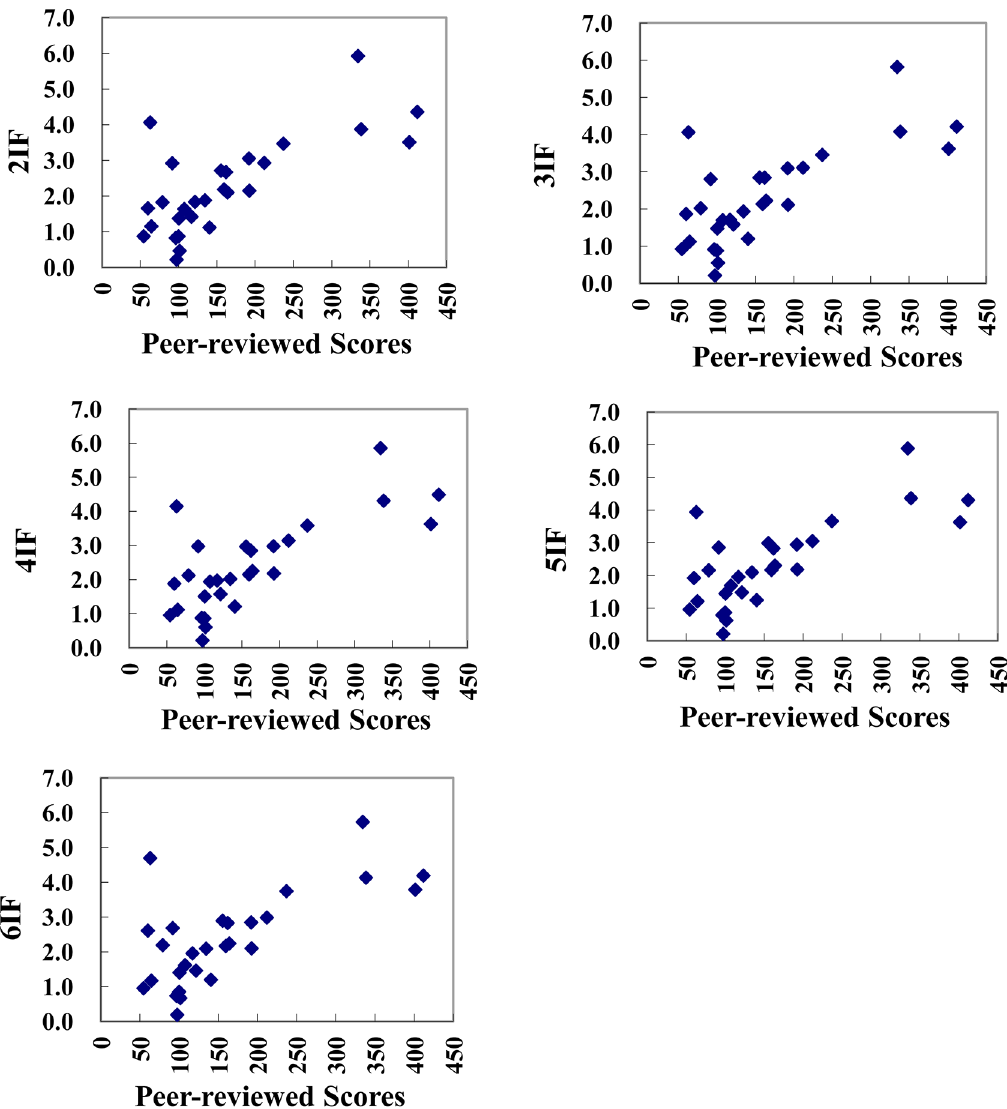
Fig 1. Correlations between the peer-reviewed scores of 28 ophthalmologic journals and impact factors with different citation time windows.